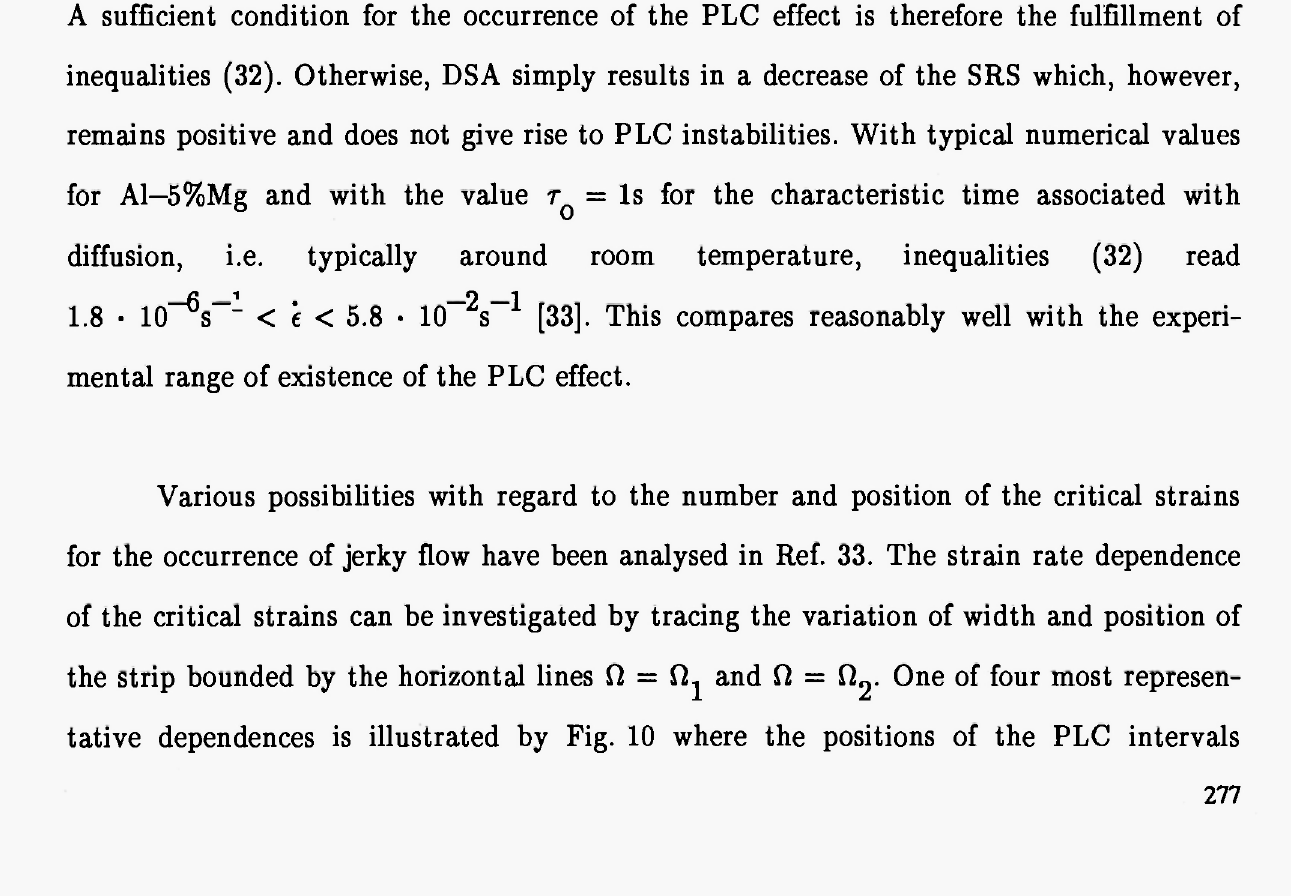
Fig. 9. Time dependence of stress in an Al—Li alloy deformed at room temperature with a constant strain rate. (a) A curve exhibiting a lower and an upper critical strain (e = 1.75· 10" 5 s-i). (b) A curve showing two regions of jerky flow separated by a smooth region (e = 2· 10